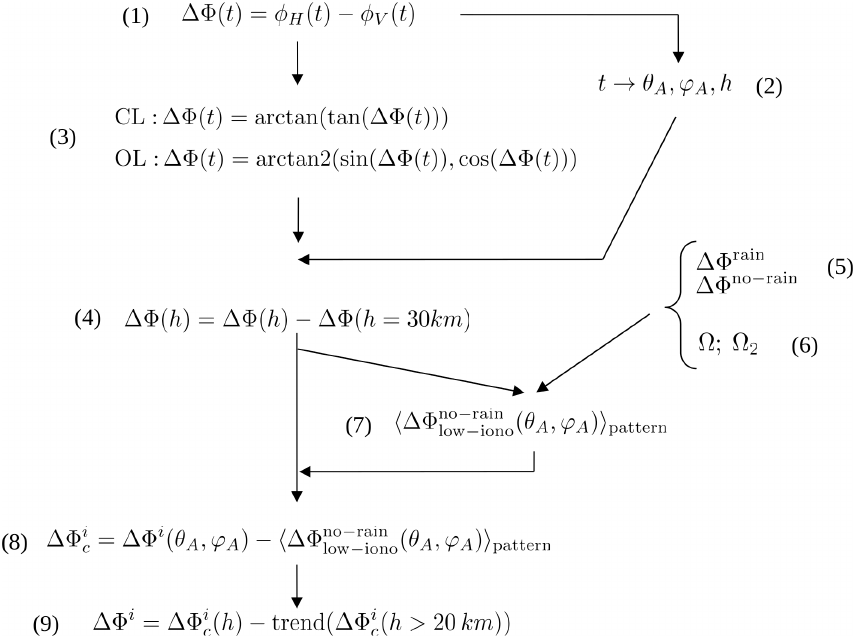
Figure 9. Block diagram identifying and describing the steps followed during calibration: (1) start with the observable: phase difference between H and V; (2) map time into other variables; (3) do correction for remaining cycle slips; (4) set the zero level at 30km; (5) and (6) do colocations with precipitation information and ionospheric activity; (7) use accumulation of free-of-rain and low-ionospheric activity measurements to create the effective antenna pattern; (8) subtract the effective antenna pattern to each measurement; and (9) correct for remaining